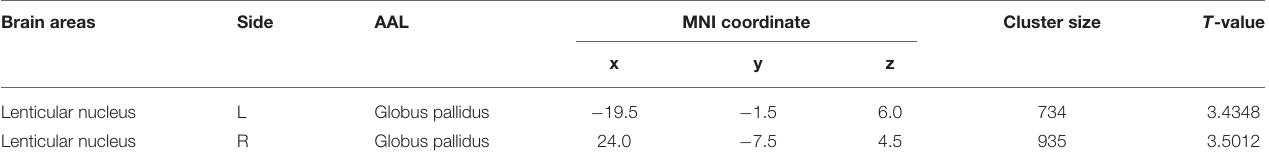
TABLE 2 | The volume of bilateral lenticular nucleus increased in OCD patients compared to HCs. Brain areas